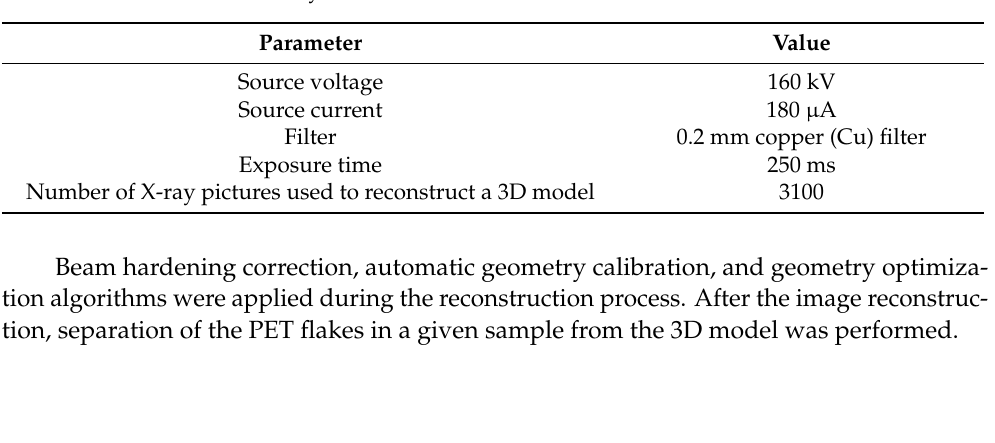
Table 4. Parameters of the X-ray CT